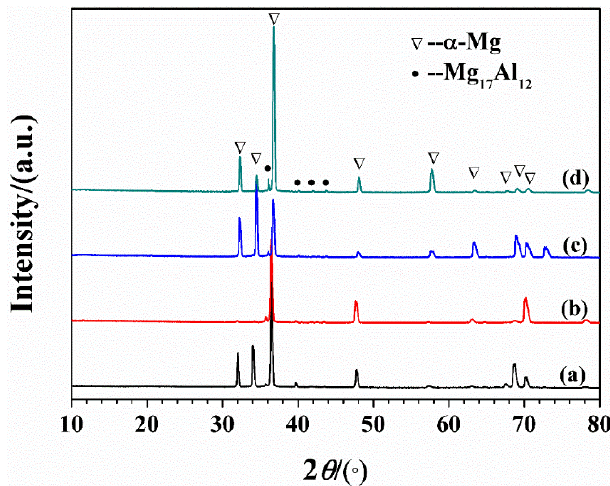
Figure 1. X-ray diffraction (XRD) patterns for AZ63 ( a ), AZI1.0 ( b ), AZI1.5 ( c ) and AZI2.0 ( d ) alloys.